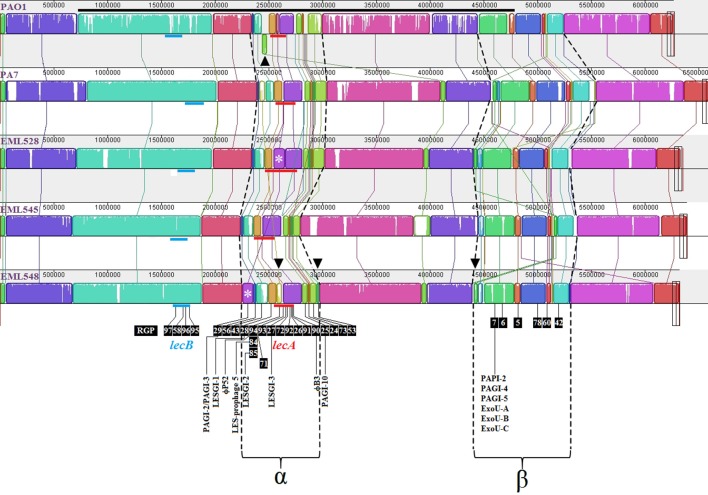
MAUVE comparisons of P. aeruginosa PAO1, PA7, EML528, EML545, and EML548 genomic organizations. DNA segment going from 727,314 to 4,788,531 of the PAO1 genome was manually inverted for a better match of syntenic groups (long black line). Colored blocks outline linked genomic regions between strains (locally collinear blocks named LCB). White regions correspond to sequences that are not aligned and probably contain sequence elements specific of a particular genome. The height of the colored profile within each LCB indicates the average degree of sequence conservation between the aligned regions. Horizontal red lines represent the lecA genomic regions localized in the analyzed genomes with inferred RGP (according to Figure 6). Horizontal blue lines represent the lecB genomic regions localized in the analyzed genomes with inferred RGP (numbers are those of the literature or from Supplementary Figure S8). α and β indicate two large regions of genomic instability. Asterisks represent PAGI-2 element identified in EML528 and EML548. The green block below the center line in PAO1 indicates a reverse complement (inverse) orientation (see arrowhead of Top Panel). Arrowheads of the Last Panel highlight major rearranged genomic blocks.